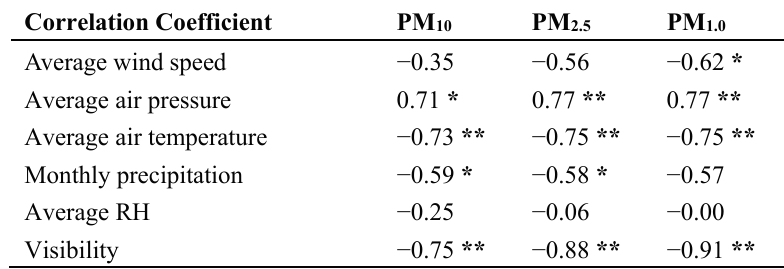
Figure 3. PM 2.5 /PM 10 ; PM 1.0 /PM 2.5 ; and PM 10 /PM 2.5 ratios. Table 1. Correlation coefficients between mass concentrations of PM 10 , PM 2.5 and PM 1.0 and average meteorological factors: wind speed, air pressure, air temperature, precipitation, RH and